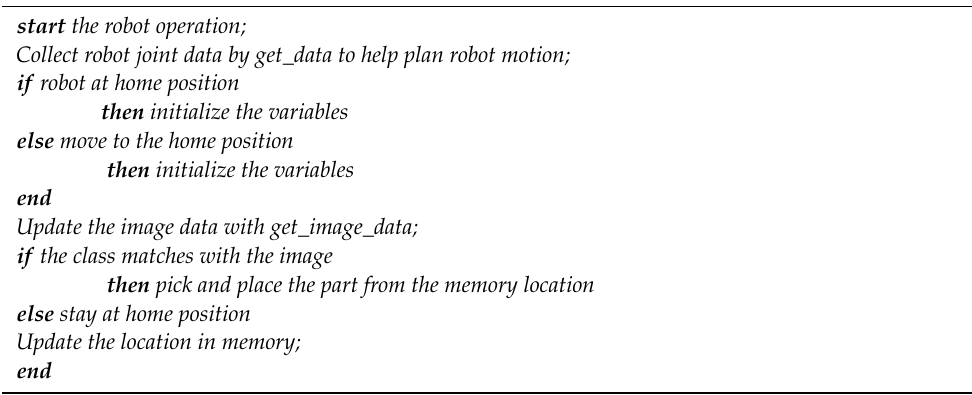
Algorithm 1: ODCA for a robot pick and place operation operating on DL